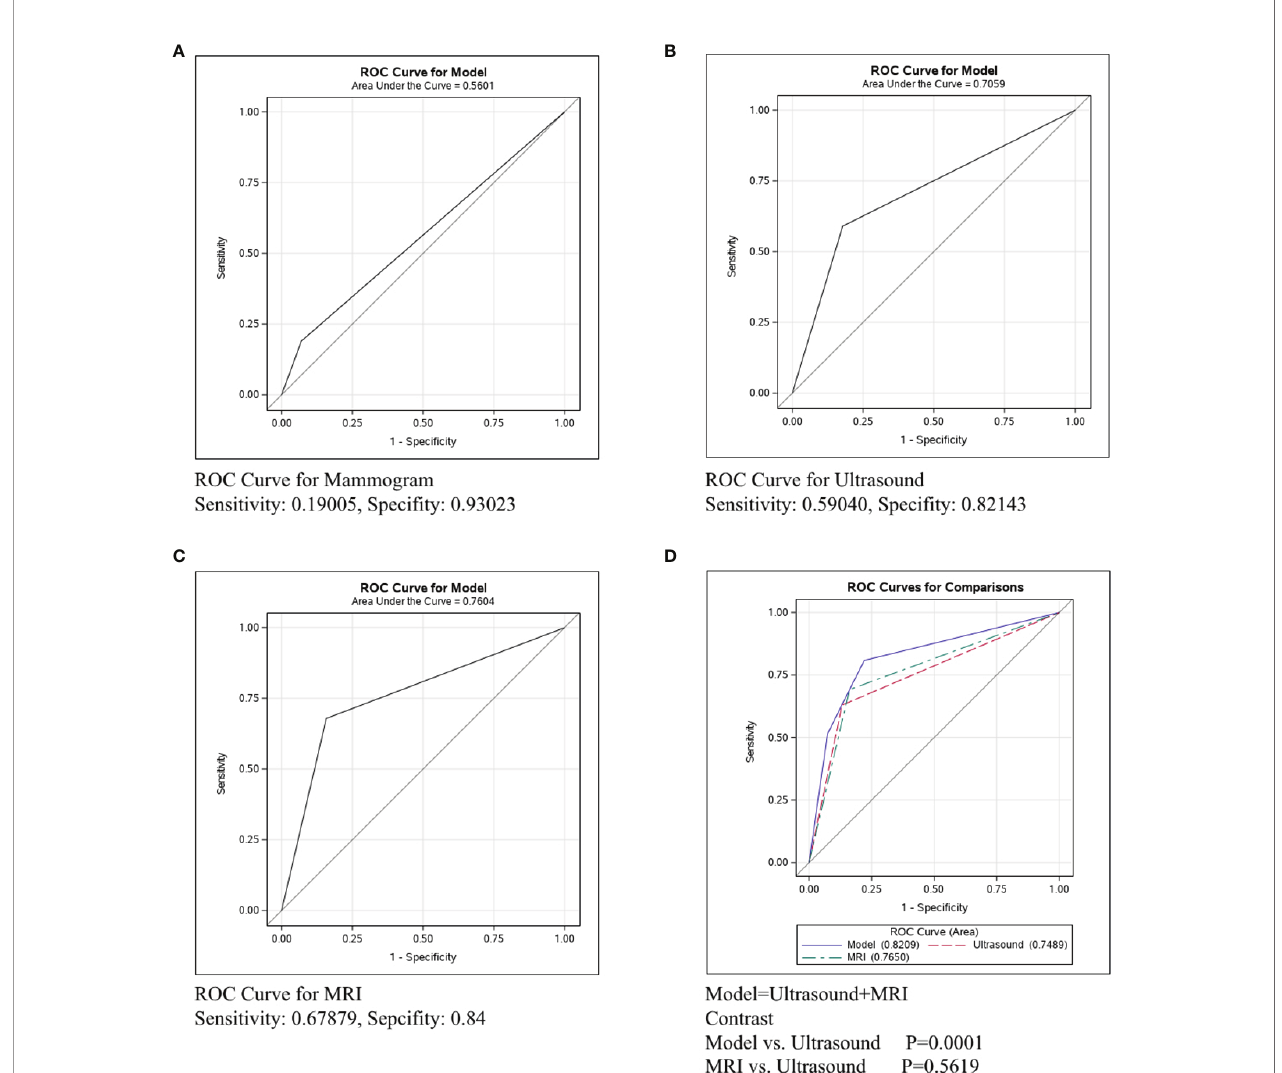
FIGURE 3 | ROC curve analysis for speci fi c imaging examination in ER/PR+Her2-subtype. The vertical axis is sensitivity, the horizontal axis is 1-speci fi city. AUC is a parameter used to measure the value of imaging examination in the prediction of axillary lymph nodes. (A) ROC curve for mammogram. (B) ROC curve for ultrasound. (C) ROC curve for MRI. (D) ROC curve for